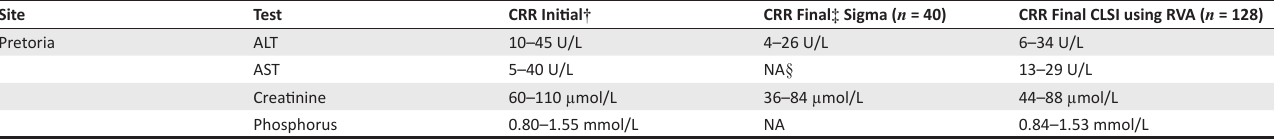
TABLE 3: Comparison of chemistry reference range from the Pretoria site obtained with the Sigma method and the Clinical and Laboratory Standards Institute method.